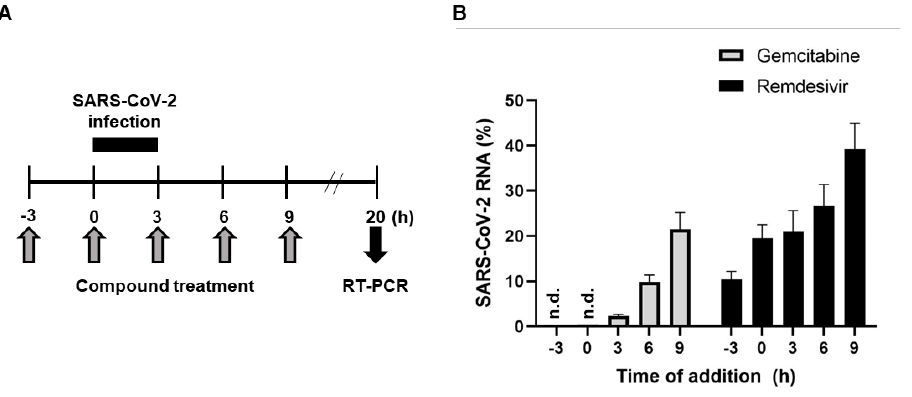
Figure 4. Time-of-addition experiment of gemcitabine. ( A ) Schematic presentation of the time course of viral infection and the compound treatment. ( B ) Quantitative RT-PCR for detecting the SARS-CoV-2 N gene. Vero cells seeded in 24 wells were infected with SARS-CoV-2 at an MOI of 0.01 for 3 h, followed by washing with PBS. In parallel, 10 μM of gemcitabine (gray bars) or remdesivir (black bars) as a control was added at 3-h intervals starting from 3 h before viral infection. At 20 h post-infection, their culture supernatants were harvested for viral RNA preparation and real-time RT-PCR. RNA quantities were calculated relative to the amount from virus-infected, mock compound-treated cells, which was arbitrarily set as 100%. Data represent means and standard deviations from three independent experiments. n.d., not detected.